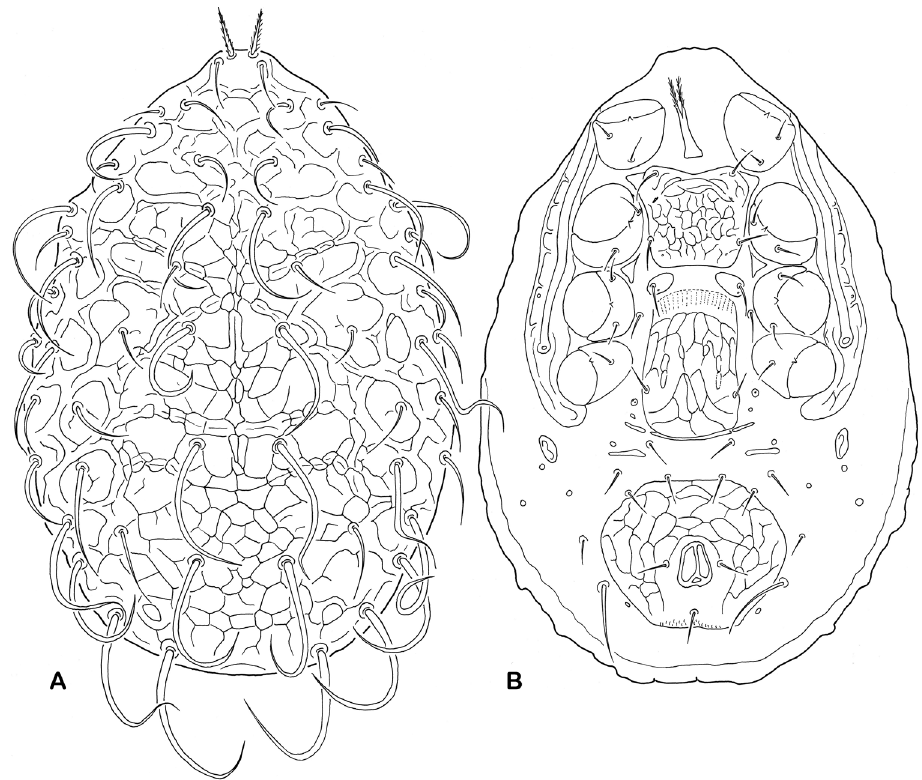
Figure 2. Ameroseius renatae sp. n., female. A Dorsal idiosoma B Ventral idiosoma. Not Ameroseius renatae sp. n.